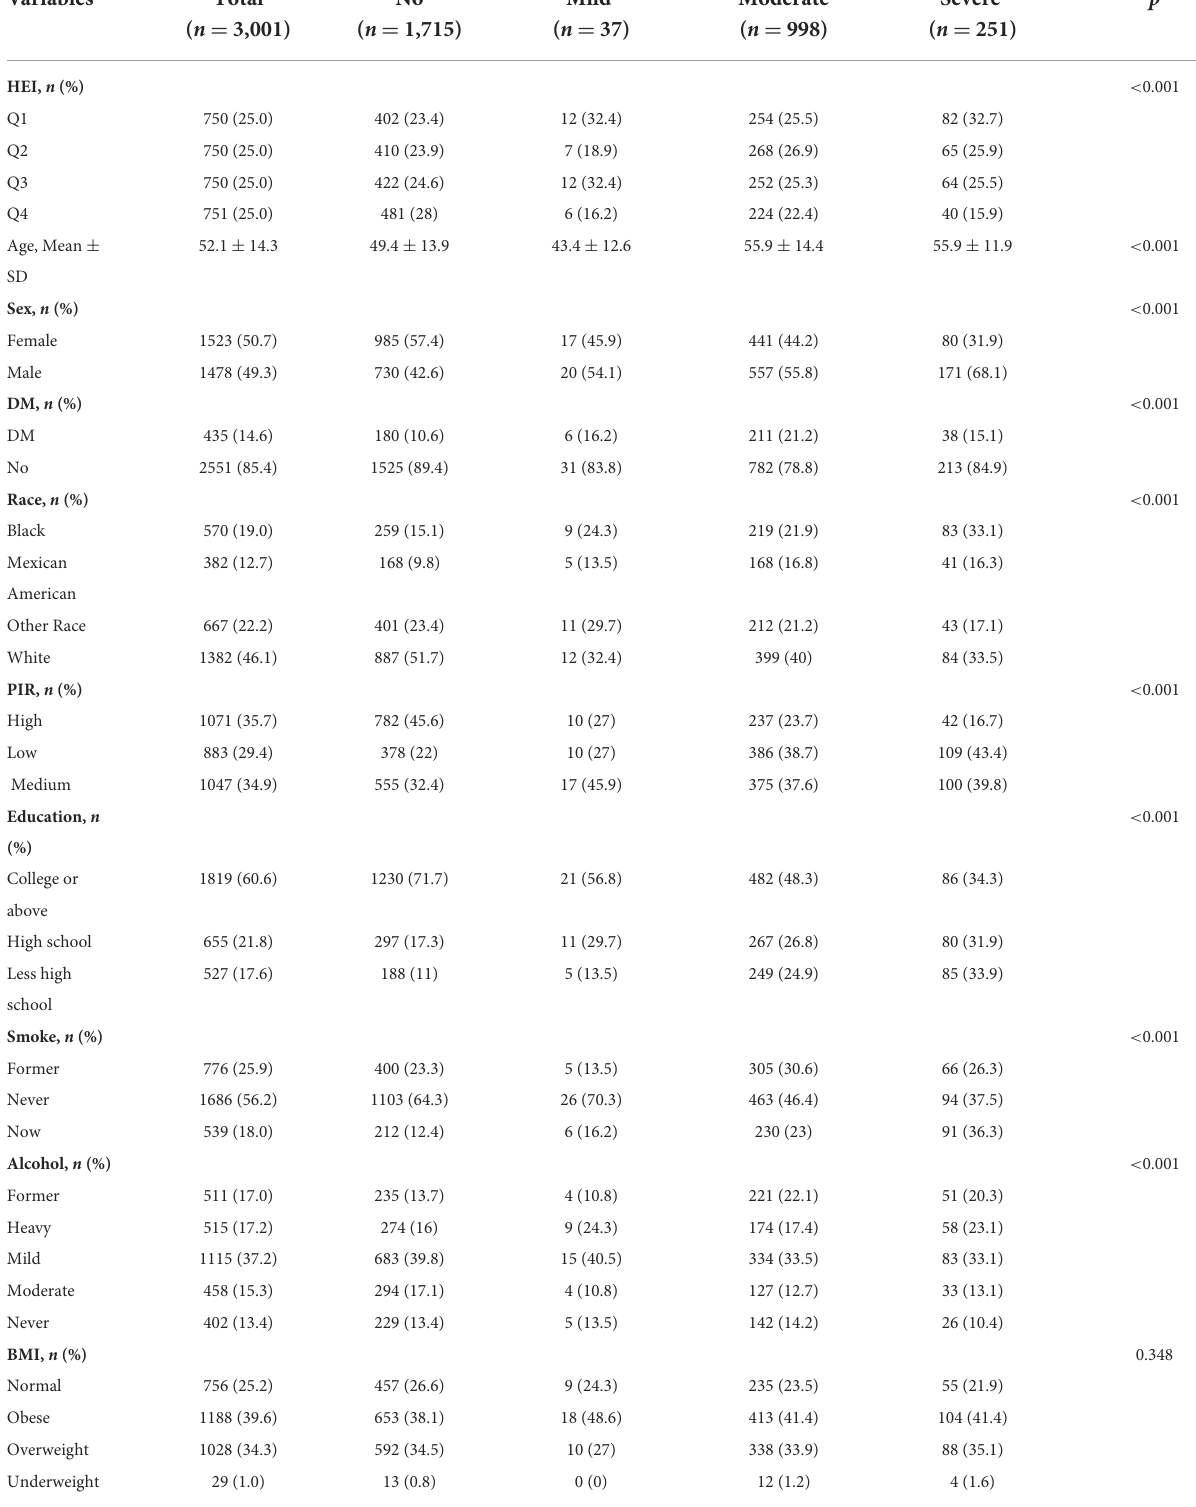
TABLE 1 Characteristics of the overall target population according to